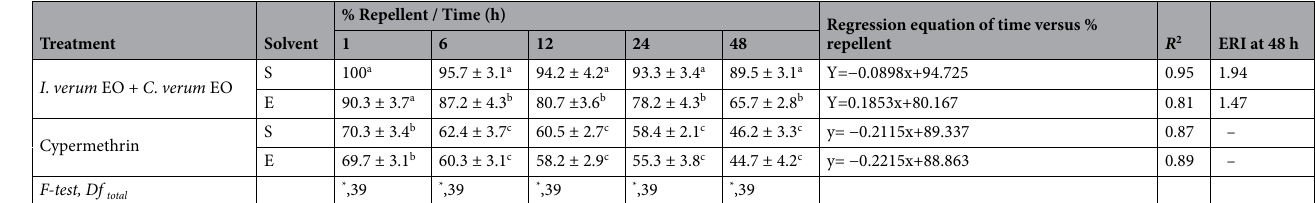
Table 6. Repellent activities against Periplaneta americana adults of a combined formulation of 5% I . verum EO + 5% C . verum EO and 10% cypermethrin, both in soybean oil and ethyl alcohol solvents. Mean percentage repellent activity within the same column followed by different letters are significantly different at P< 0.05 (ANOVA and Tukey’s post hoc test). ERI Effective repellent index, S Soybean oil formulation, E Ethyl alcohol formulation, R 2 Regression coefficient, * Significantly different at P <